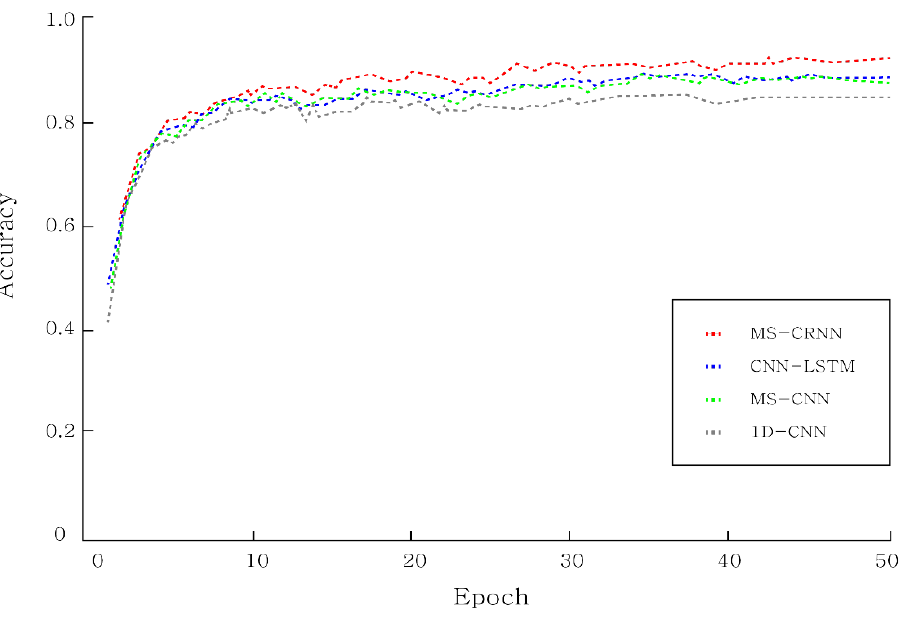
Figure 10. Results of the experiment in the denoising state.